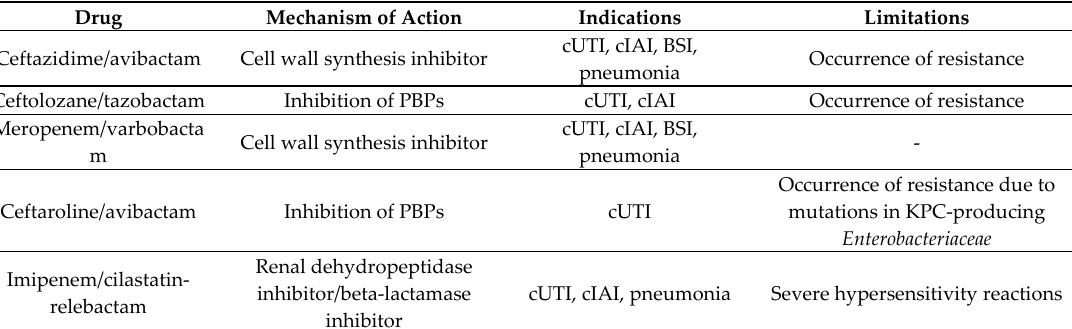
Table 1. Current promising antibiotics in treating carbapenem-resistant Enterobacteriaceae (CRE) infections 1